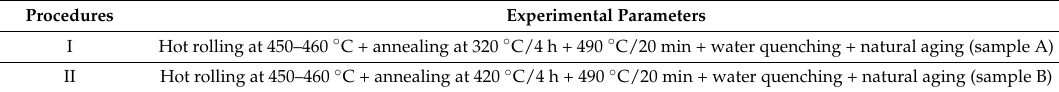
Table 1. Experiment procedures of hot rolled Al-Cu-Mg-Ag alloy sheet.